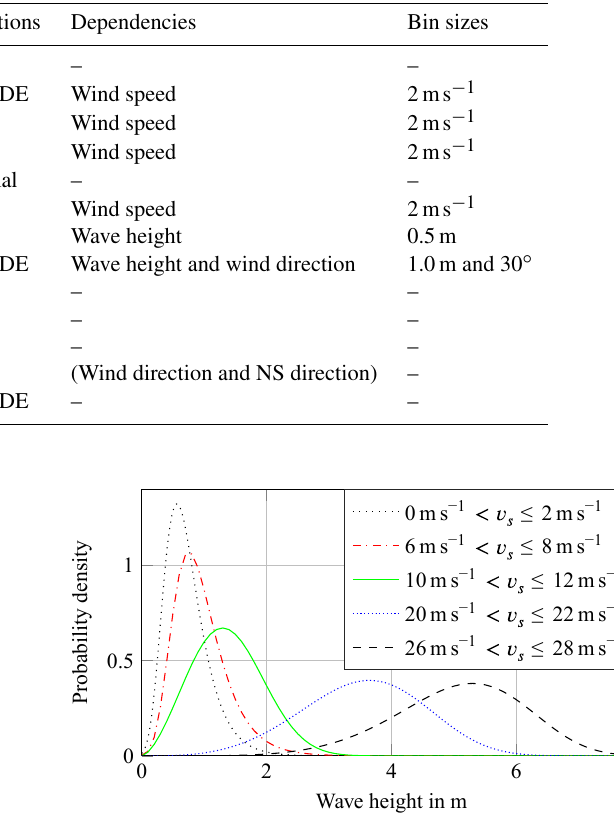
Figure 4. Weibull distributions for the wind speeds for all three sites. Figure 5. Distribution of the significant wave height for different wind speeds and the FINO1 site. For v s ≤ 10ms − 1 , Gumbel distri- butions are applied. For higher wind speeds, Weibull distributions fit the data more